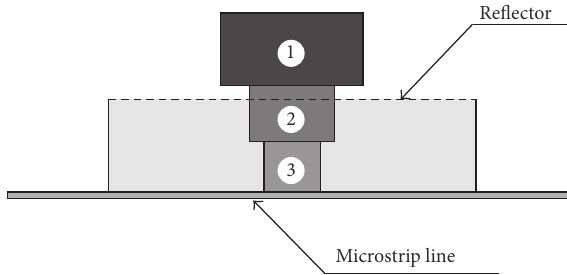
Figure 47: Geometry of the wideband high-gain stacked cylindrical dielectric resonator antenna [194]. The microstrip line adopted to excite the antenna is also indicated in the